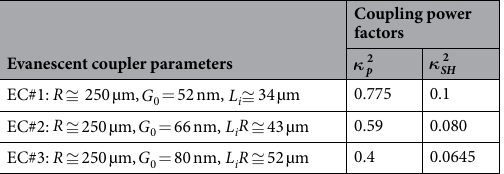
Table 2. Pump and SH coupling factors at 2.29 µ m and 1.145 µ m.